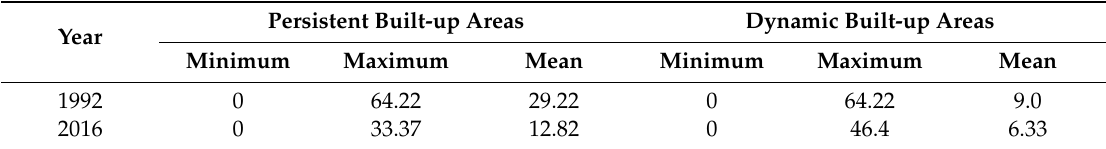
Table 2. The radiance values of NTL data between dynamic and persistent built-up areas.